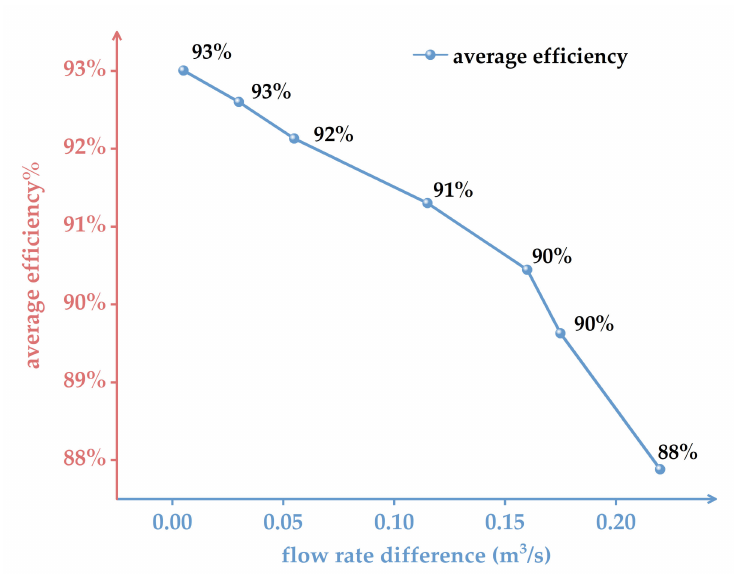
Figure 8. Relationship curve between average efficiency and flow difference.